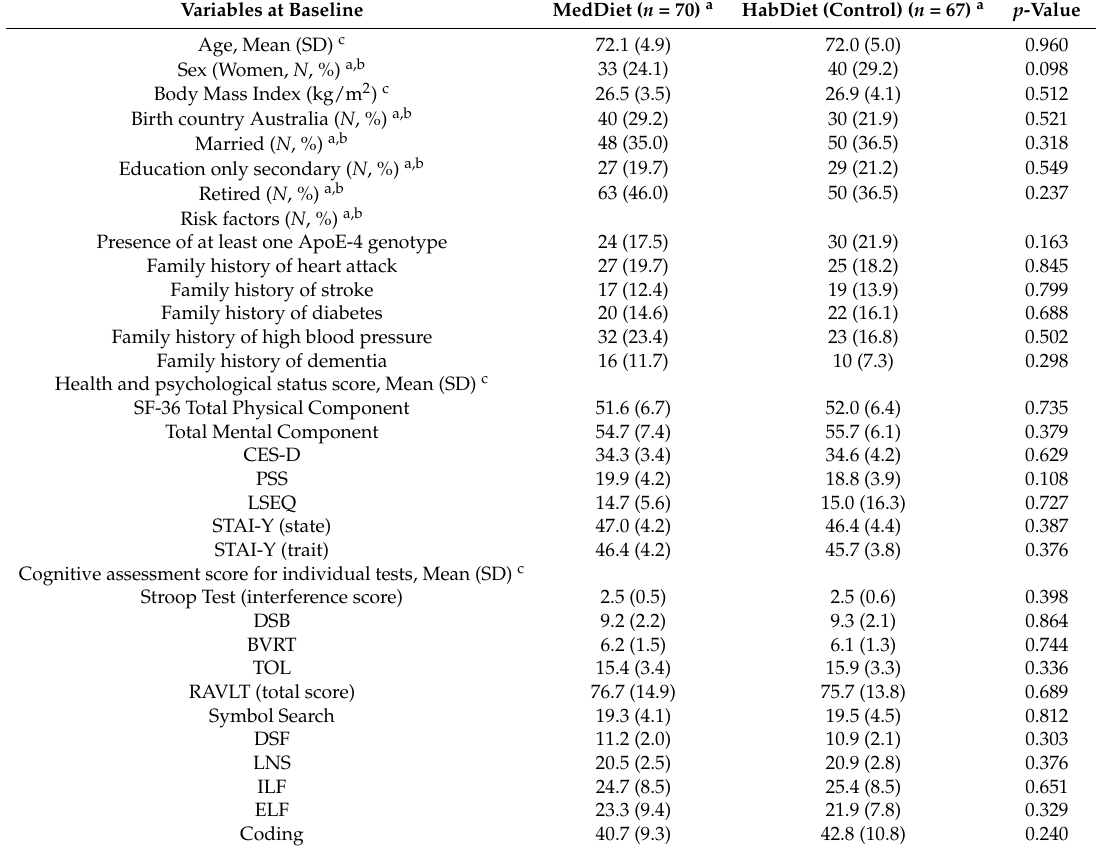
Table 1. Baseline characteristics of participants according to allocated group.